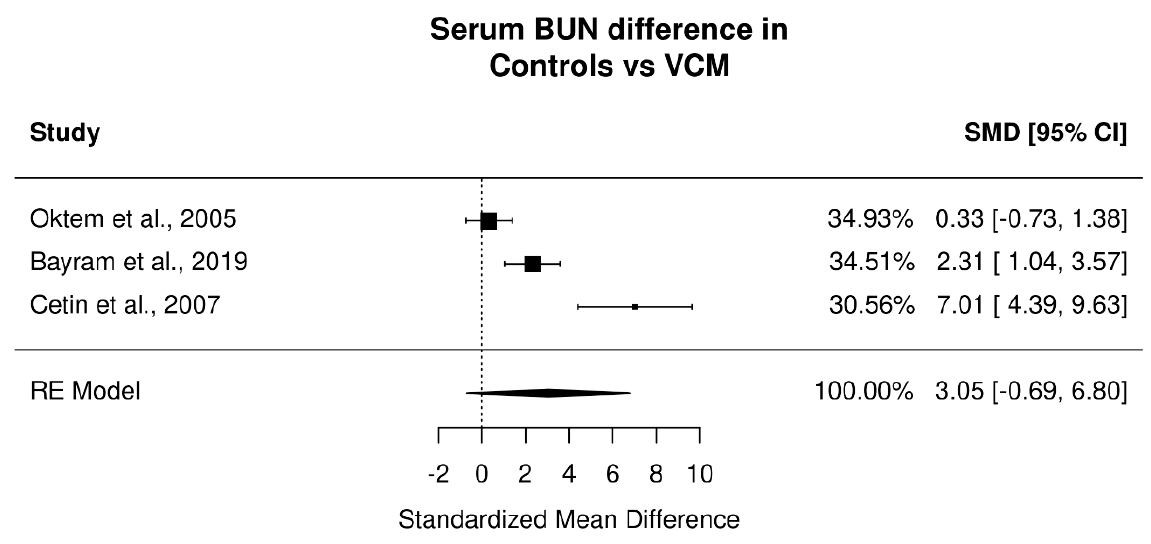
Figure 2. Effect of vancomycin on serum creatinine in animals receiving vancomycin vs. controls. Presented in plots Standardized Mean Difference and 95% confidence intervals [25,28,32,34].